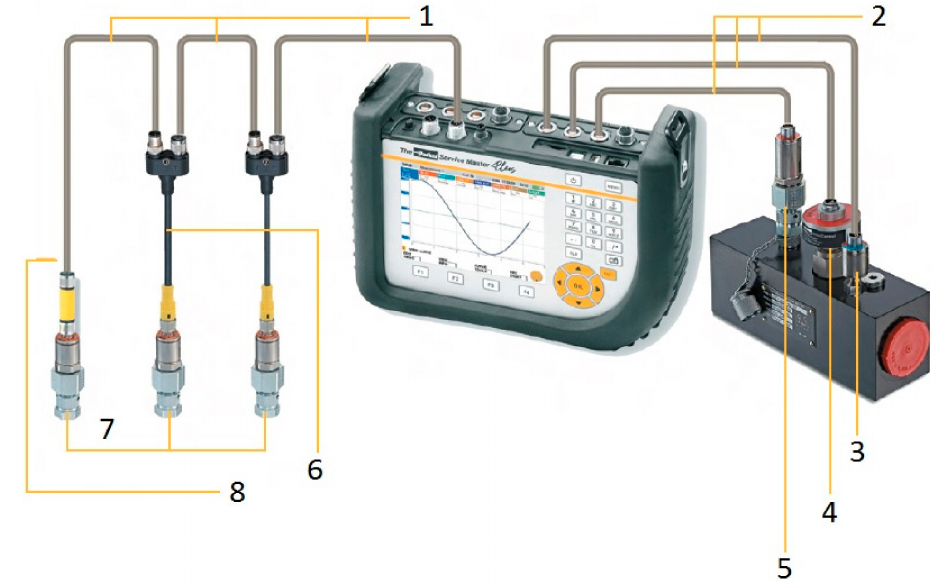
Figure 7. The portable measuring device, where 1—CAN connection cable; 2—analogue connec- tion cable; 3—analogue temperature sensor; 4—analogue turbine flow meter; 5—analogue pres- sure/temperature sensor; 6—CAN Y-junction; 7—CAN pressure/temperature sensor; and 8—CAN terminating resistor.